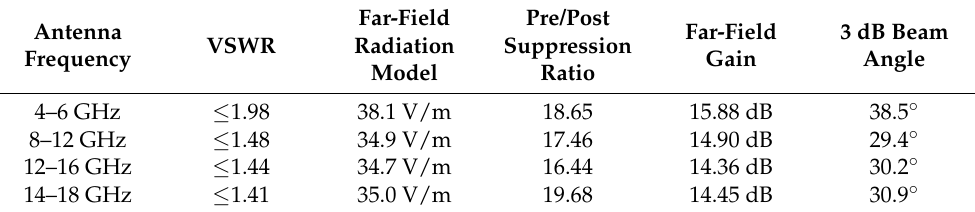
Table 3. Simulation results of pyramid horn antenna